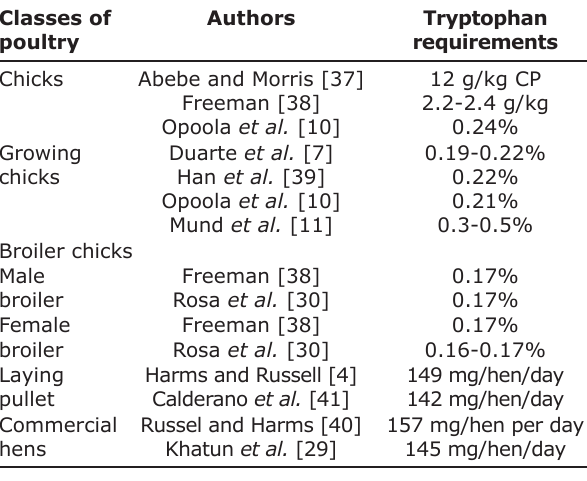
Table-3: Tryptophan requirement for classes of